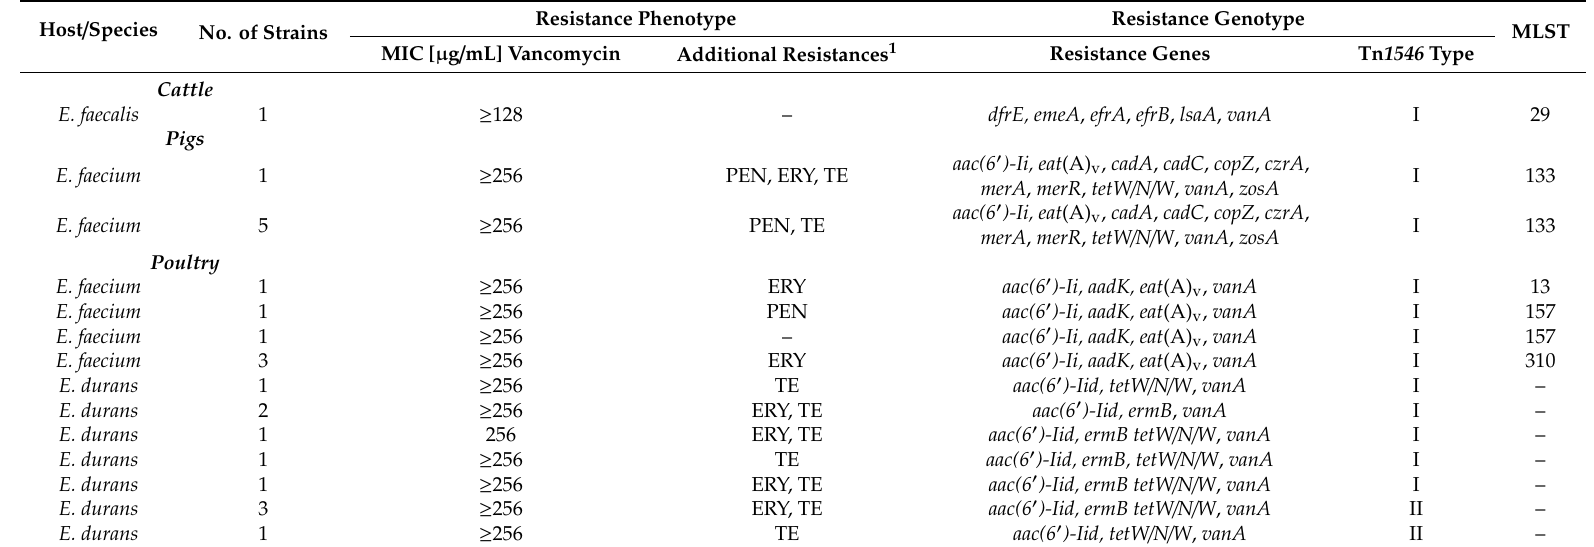
Abbreviations: aac(6 (cid:48) )-Ii and aac(6 (cid:48) )-Iid : genes for aminoglycoside N-acetyltransferases; aadK, aminoglycoside 6-adenylyl-transferase; cadA , cadC, cadmium resistance genes; cop , copper resistance gene; czrA , metal transport repressor gene; dfrE , dihydrofolate reductase gene; eat (A)v, allelic variant of eat (A) gene for resistance to lincosamides, streptogramins A, and pleuromutilins (LSAP); emeA , enterococcal multidrug resistance e ffl ux gene; efrA , efrB , ABC multidrug e ffl ux pump genes; ermB , gene for 23S ribosomal RNA methyl-transferase; lsaA , active e ffl ux ABC transporter gene for intrinsic LSAP resistance; merA , merR , mercury resistance genes; MIC, minimal inhibitory concentration; MLST, multilocus sequence type; tetW / N / W , mosaic tetracycline resistance gene and ribosomal protection protein; vanA , vancomycin resistance gene; zosA , zinc transporter